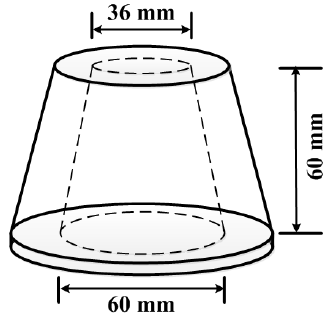
Figure 13. Geometry of cone mould used for slump flow test.